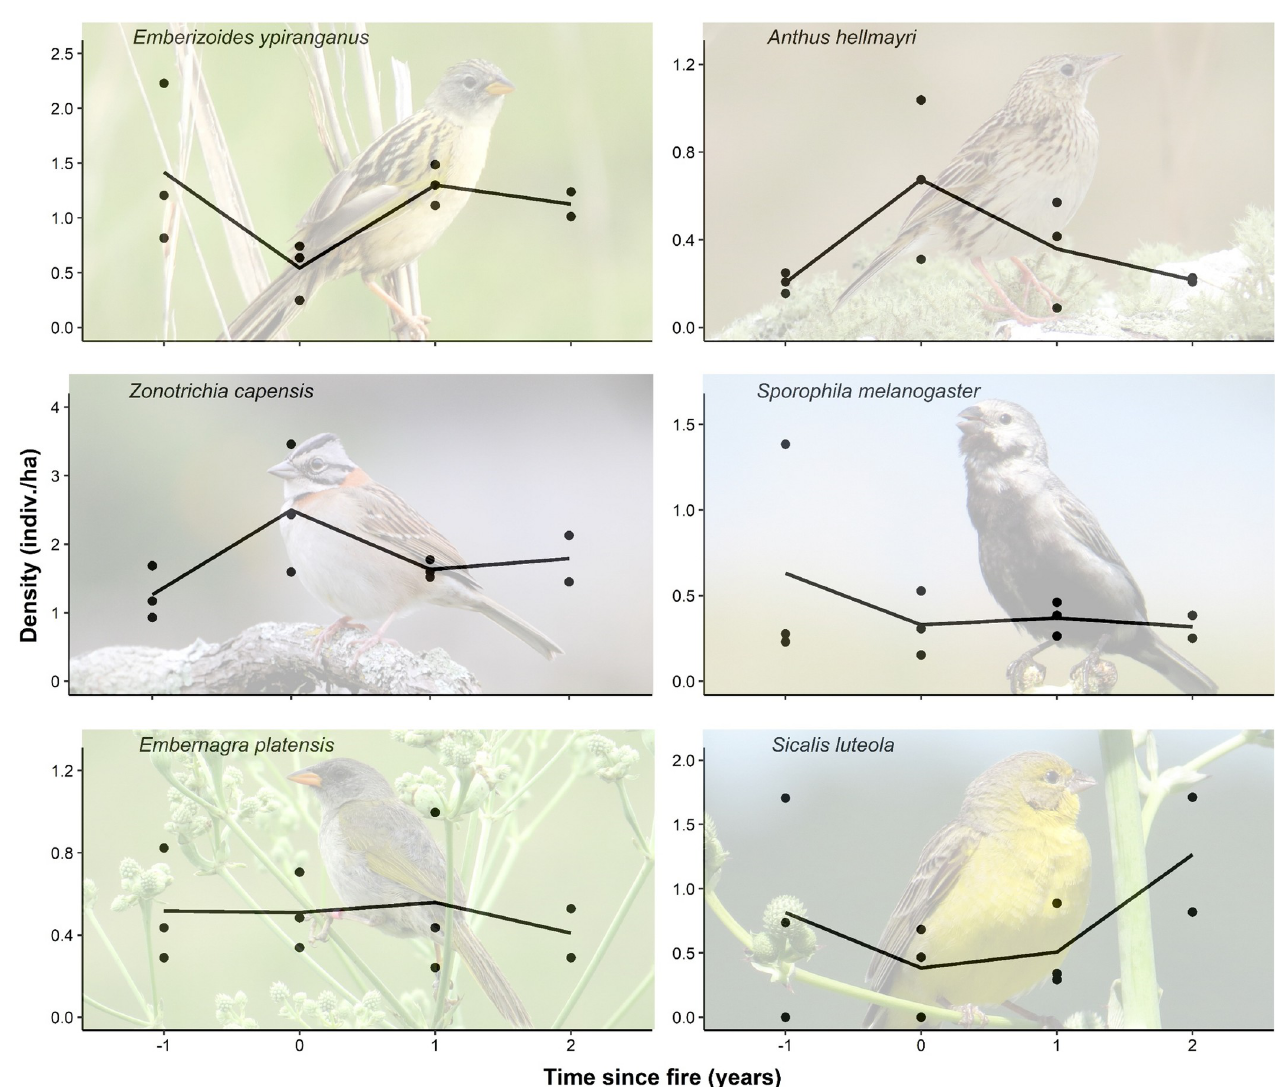
Fig 4. Density of six grassland birds one year before (“-1”), just following (“0”), and for two years after fire in highland grasslands in northeastern Rio Grande do Sul state, Brazil. Points represent the density of the species in the areas burned only once during the study at different times since fire. Line represents the mean density of the species in each time since fire. Only densities of E . ypiranganus , A . hellmayri , and Z . capensis varied significantly over time (p < 0.05), based on linear mixed